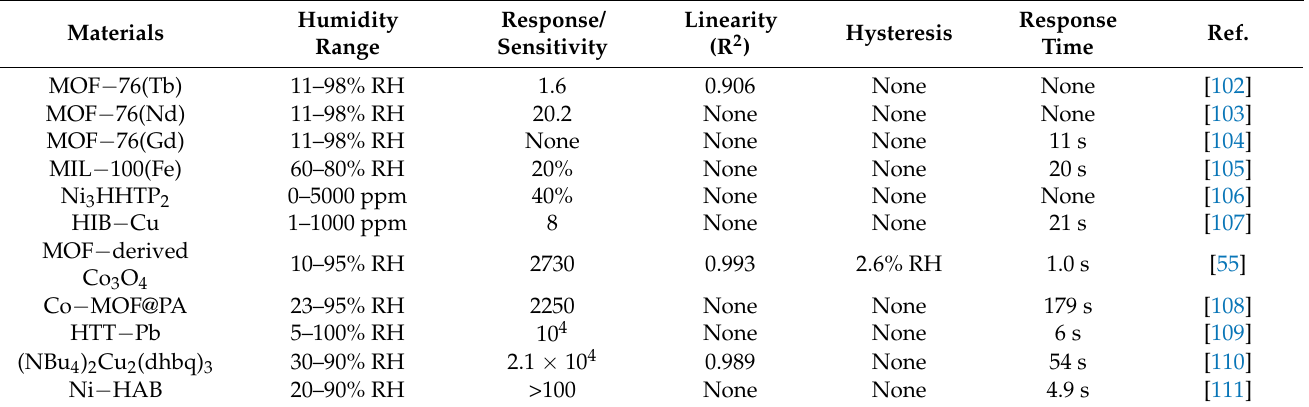
Table 3. Sensing properties of MOF − based resistive − type humidity